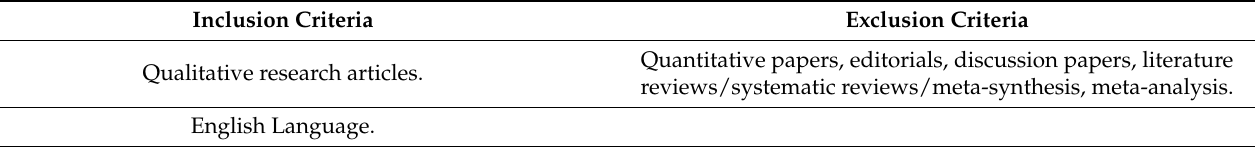
Table 1. Initial Inclusion/Exclusion